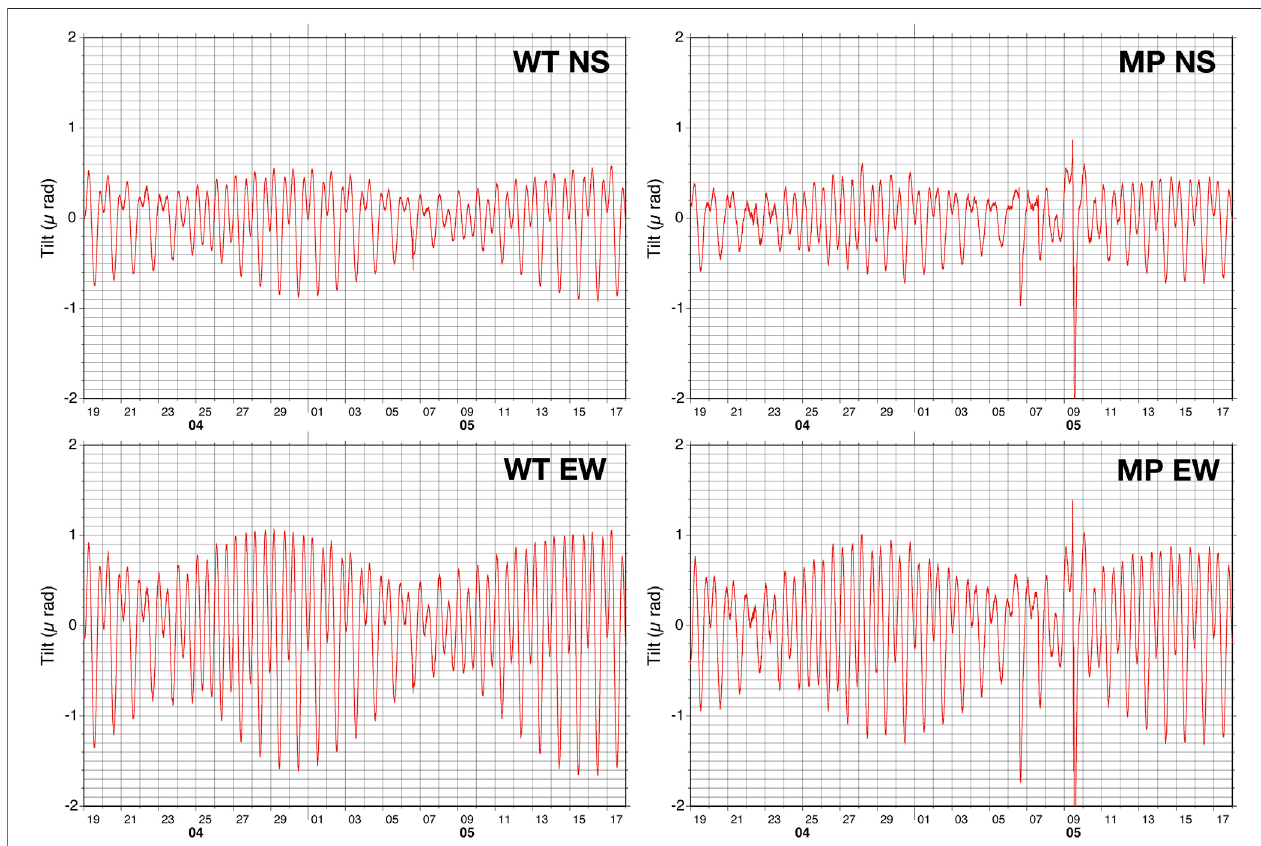
FIGURE 5 | The land vault test of this method. A 2 month test of the broadband sensor for the BBOBST-NX (MP) compared with the water tube tilt-meter (WT) in the same vault. The two large disturbances on May 6 and 9 were due to other human works in the same seismometer room that we used.